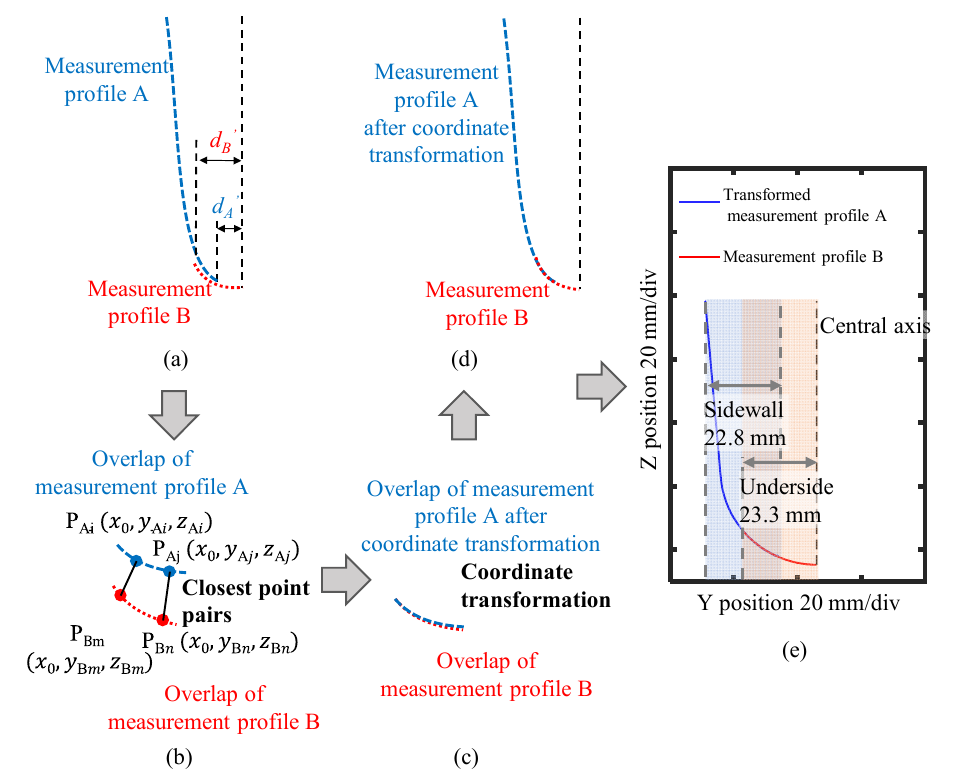
Figure 18. Schematic and experimental results of the point cloud registration algorithm for inner profile stitching. ( a ) Schematic of obtaining an overlap measurement profile of probe A and probe B; ( b ) schematic of finding the closest point pairs of the point cloud registration algorithm; ( c ) schematic of coordinate transformation of the point cloud registration algorithm; ( d ) schematic of coordinate transformation for Measurement profile A; ( e ) experimental results of the point cloud registration algorithm for inner profile stitching.